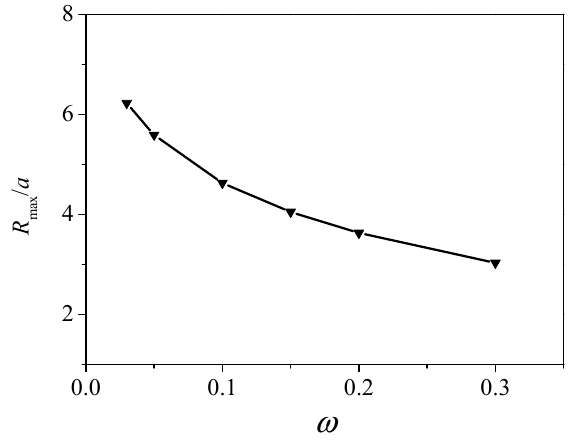
Figure 14. MWR along the vertical wall for multi-crest wave train cases of different wave frequencies.